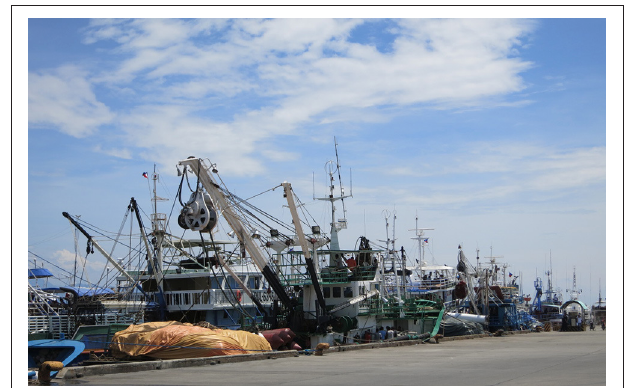
FIGURE 2 | Purse seine boats docked side by side at the General Santos City Fish Port Complex preparing for deployment to the High